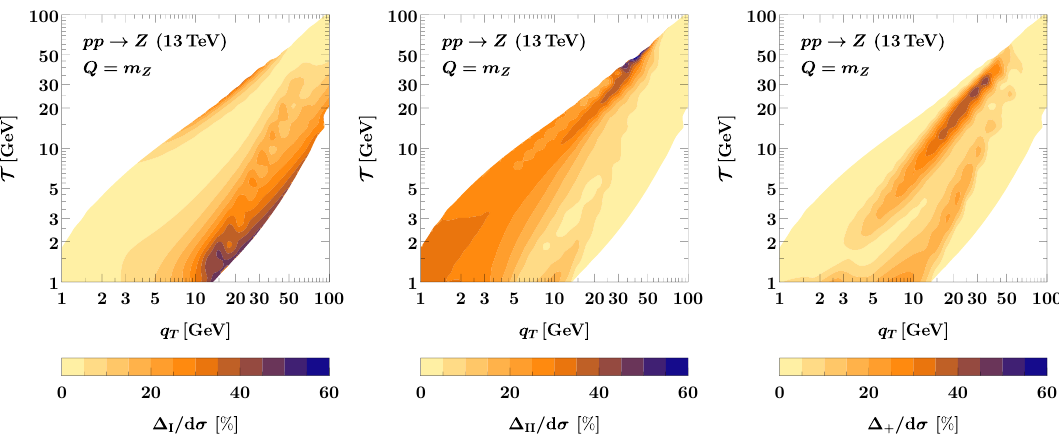
Figure 17 . Breakdown of resummation uncertainties contributing to the relative uncertainty in the top right panel of (cid:12)gure 16, showing (from left to right) (cid:1) I , (cid:1) II , and (cid:1) + . As in (cid:12)gure 16 we leave regions blank where the cross section is small.